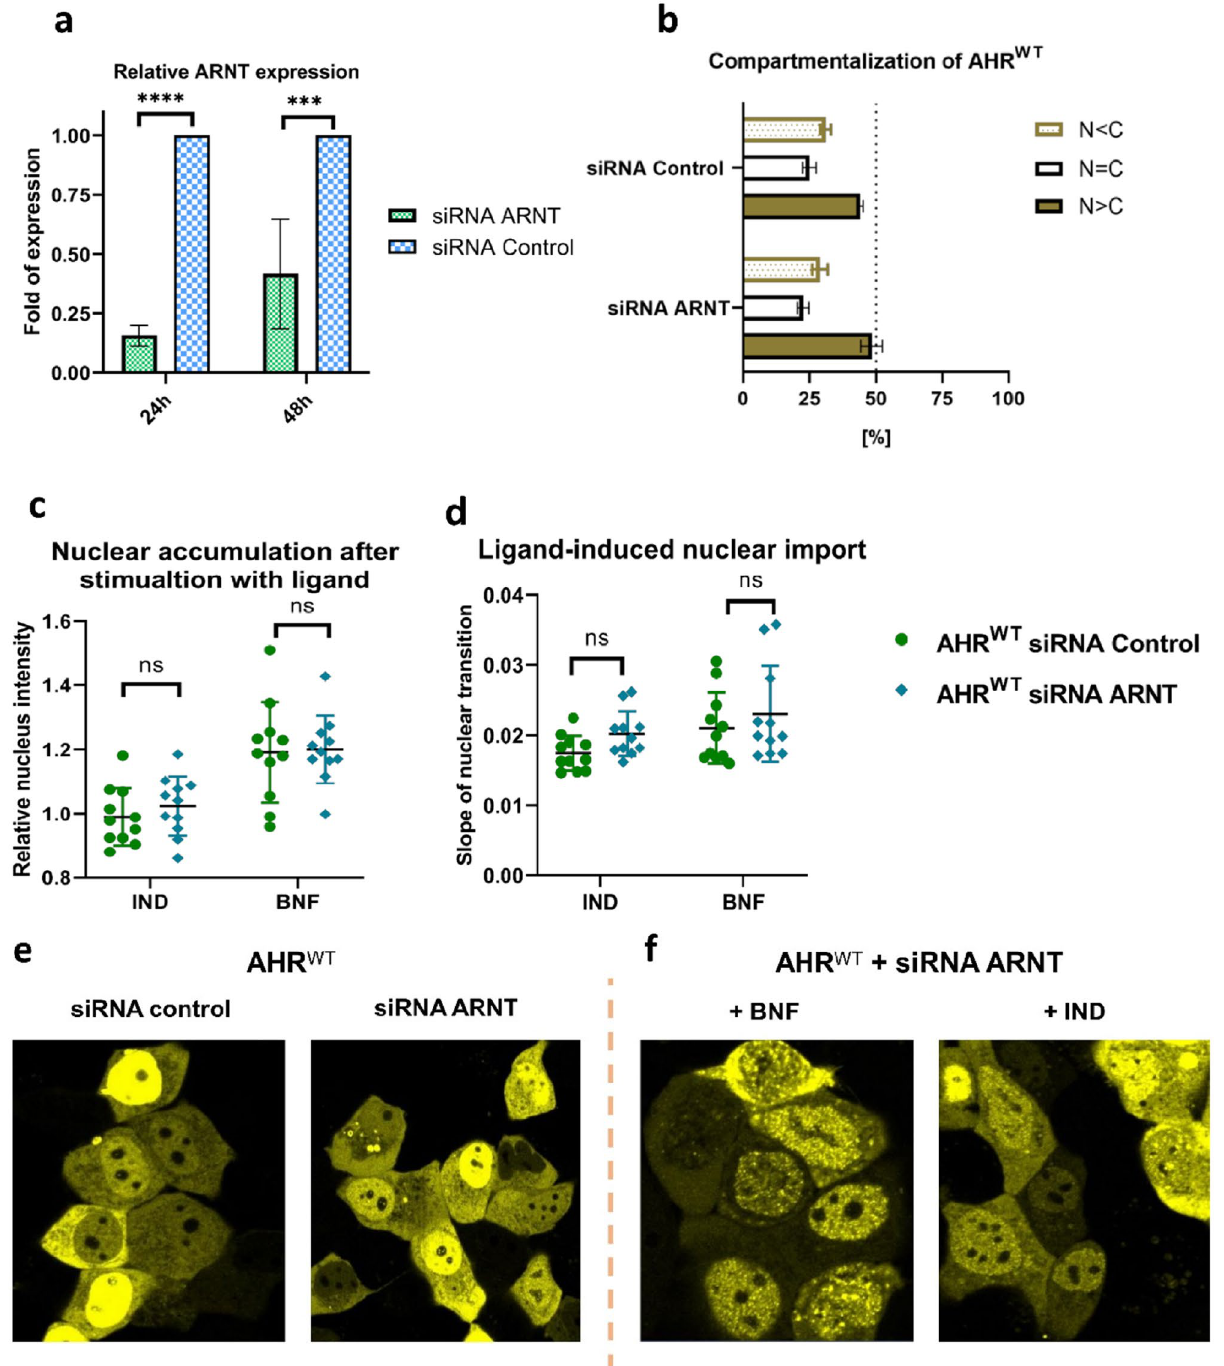
Figure 5. Down-regulation of ARNT is not critical for the AHR nucleo-cytoplasmic translocation in MCF-7 cells. ( a ) Relative ARNT mRNA level determined by qPCR in MCF-7 ΔAHR cells after transfection with siRNA against ARNT and control siRNA, respectively. Values were standardized against HPRT and normalized against control siRNA transfected cells. Each bar depicts the mean of three biological replicates ± S.D. (two way ANOVA, Dunnett’s multiple comparisons test, *** p < 0.001,**** P < 0.0001). ( b ) Intracellular distribution pattern of EYFP-tagged AHR WT in MCF-7 ΔAHR cells are shown. At least 300 transfected cells are randomly selected and sorted according to the following classification: N > C predominantly nuclear; N = C equal distribution; N < C predominantly cytoplasmic. Each bar represents the mean + /- S.D. of three biological experiments. Depicted are relative nuclear intensity ( c ) and slope ( d ) of time-lapse measurements after stimulation with 10 µM indirubin (IND) or 10 µM β-naphthoflavone (BNF) in control siRNA and ARNT siRNA transfected MCF-7 ΔAHR cells. The presented data contains individual values and the mean + /- S.D. of 11 cells. ( e ) Snapshots of MCF-7 ΔAHR cells before and after knocking down the ARNT gene. ( f ) Snapshots of the MCF-7 cells after stimulation with BNF and